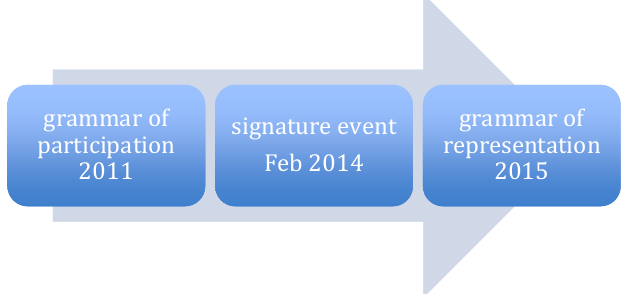
Figure 1 . The signature event and the two phases of